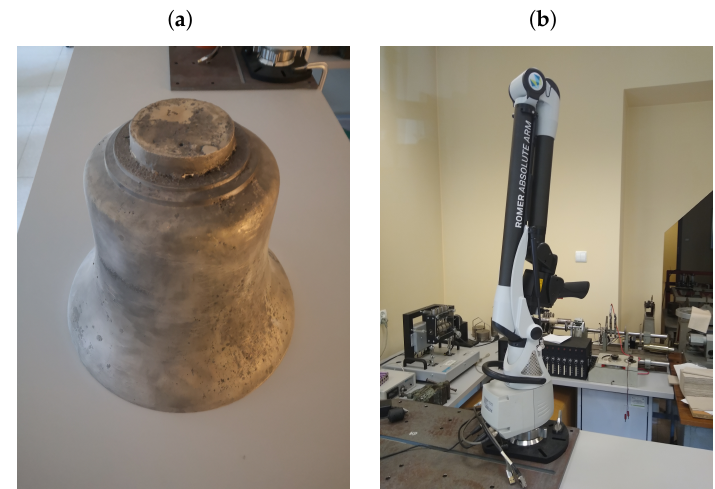
Figure 2. ( a ) CuSn20 bell during uniform gloss and color of the surface; ( b ) ROMER Absolute ARM. Table 2. Specifications of scanning sensor (RS3)